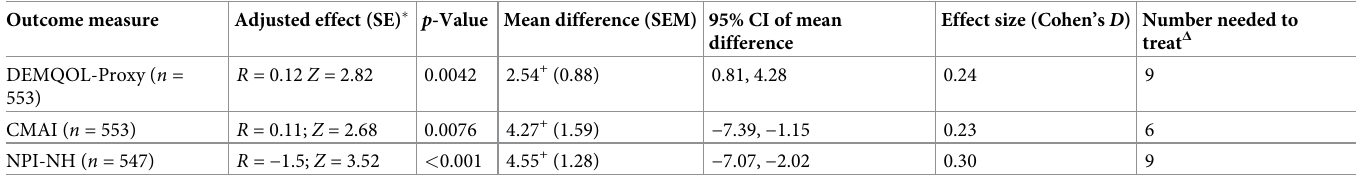
Table 2. Effect estimates of WHELD intervention in comparison to TAU on primary outcome and key secondary outcome measures (multiple imputation analysis). Outcome